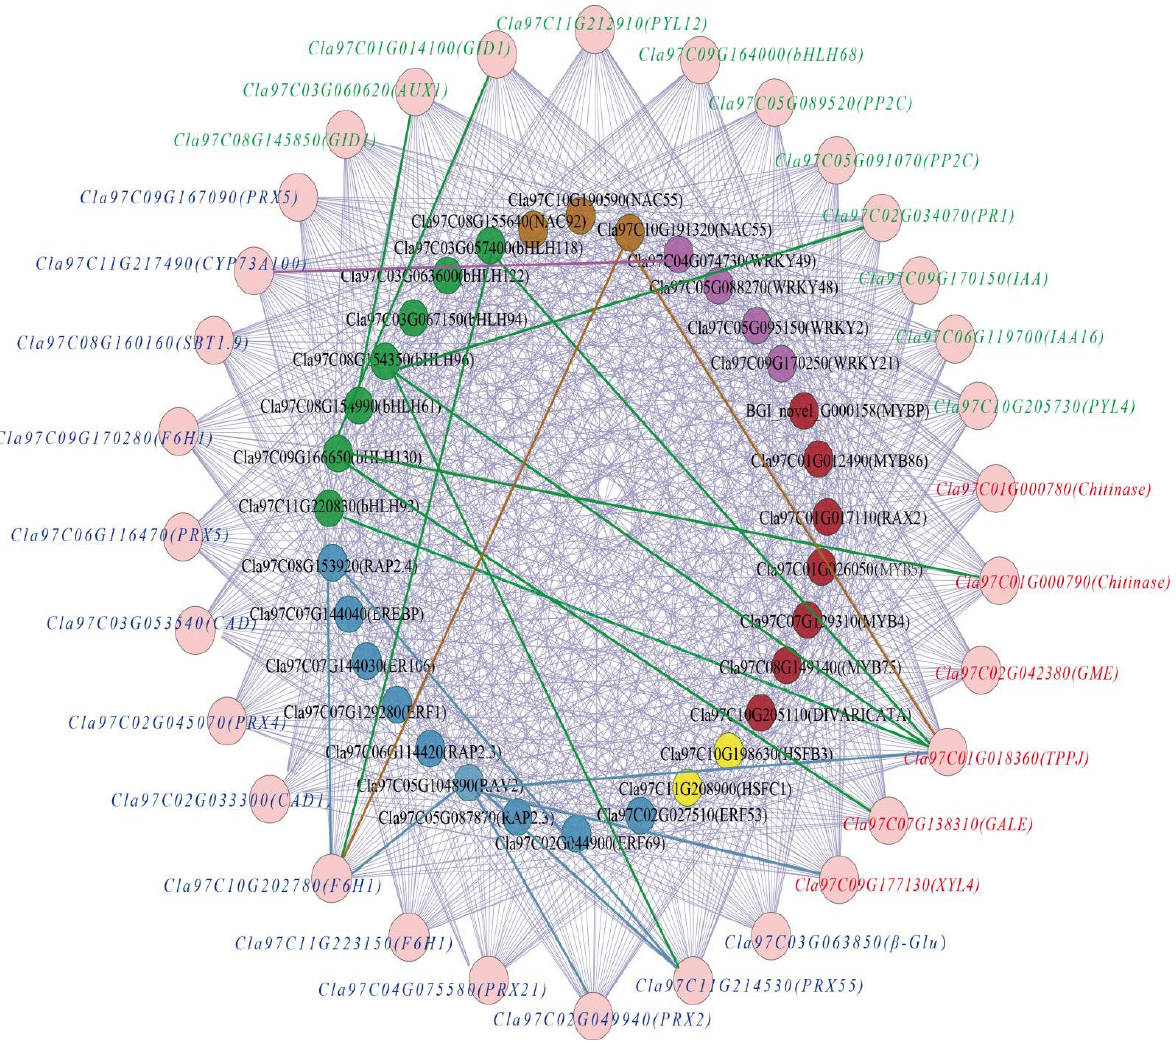
Figure 11. Co ‐ expression network analysis of TFs and a series of DEGs with correlation coefficient >0.9. The internal green, blue, yellow, red, purple, and brown dots represent bHLH TFs, AP2 ‐ EREBP TFs, HSF TFs, MYB TFs, WRKY TFs, and NAC TFs, respectively. Lines marked with different colors represent TFs that are up ‐ regulated, and the color of the line is represented by the color of the corresponding TF. The external red, green, and blue fonts represent sugar ‐ related DEGs, plant ‐ hormone ‐ related DEGs, and lignin ‐ related DEGs, respectively.